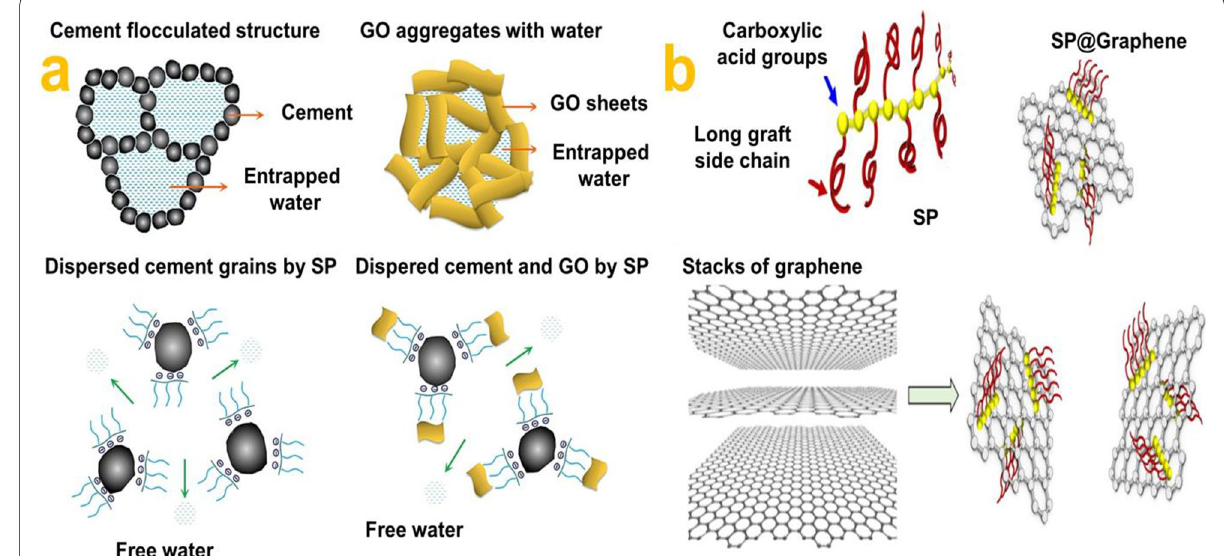
Fig. 4 Schematic diagram of ( a ) SP dispersing GO nanosheets and cement grains at the same time [100]. (Copyright 2018 Elsevier). And ( b ) the dispersion of graphene by SP [109]. (Copyright 2018